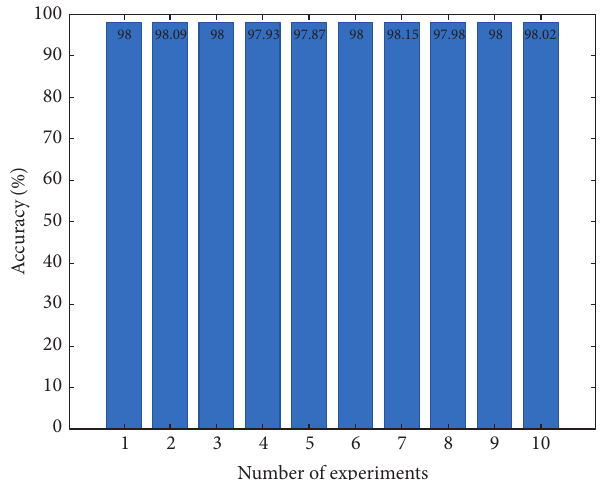
Figure 12: Accuracy of the proposed method.